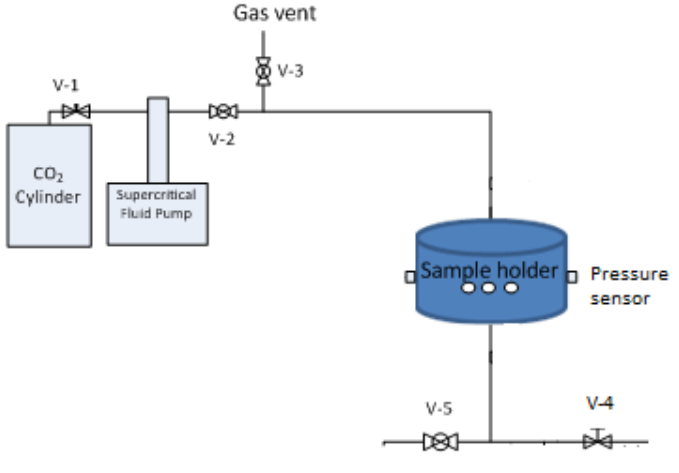
Figure 2. Experimental set-up for concrete carbonation [28].